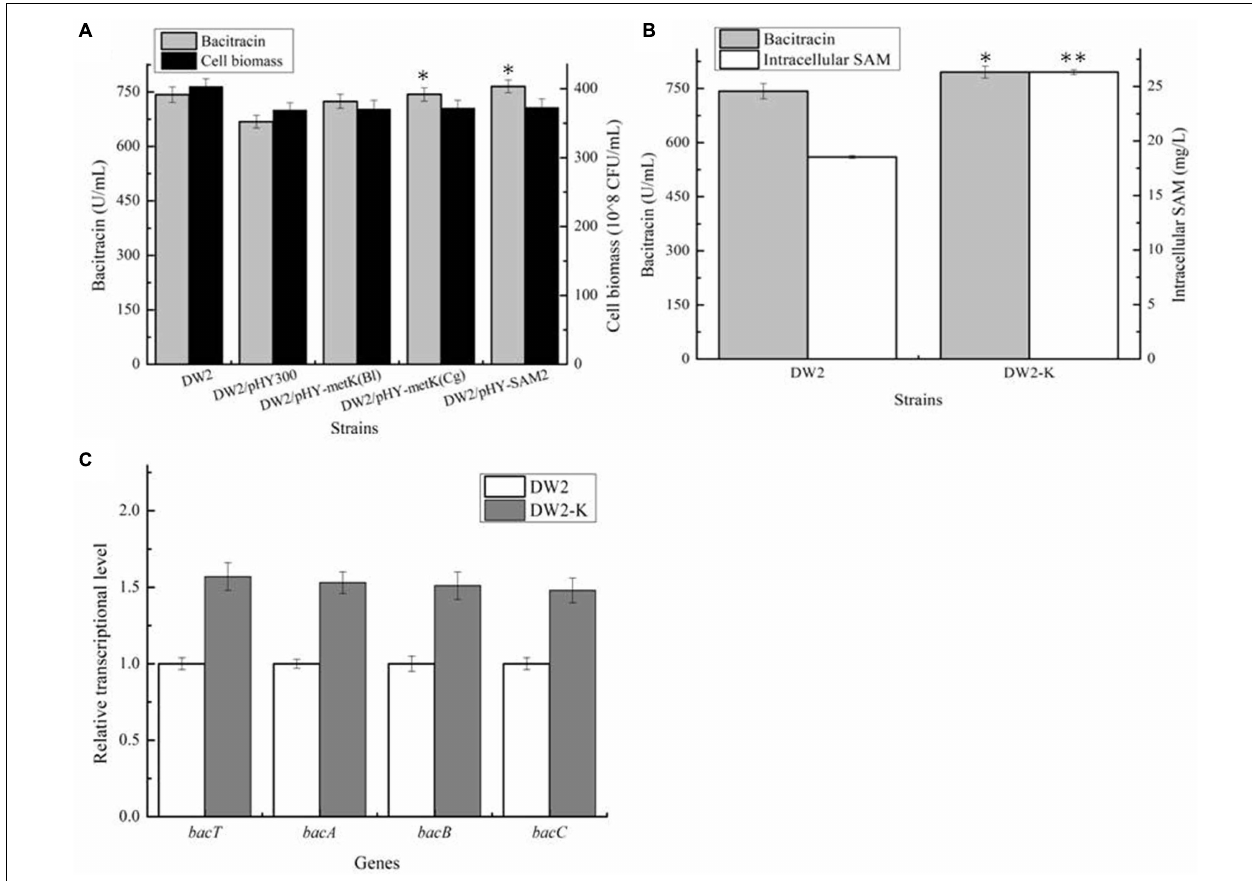
FIGURE 3 | Effects of strengthening SAM synthetase expression on SAM accumulation and bacitracin production. (A) Effects of SAM synthetase overexpression on bacitracin yield and cell biomass, (B) Effects of integrated overexpression of SAM2 from S. cerevisiae on bacitraicn yield, cell biomass and SAM accumulation, (C) Effects of SAM2 overexpression on the transcriptional levels of bacitracin synthetase genes bacT , bacA , bacB, and bacC . ∗ P < 0.05 and ∗∗ P < 0.01 indicate the significance levels between recombinant strains and control strain.